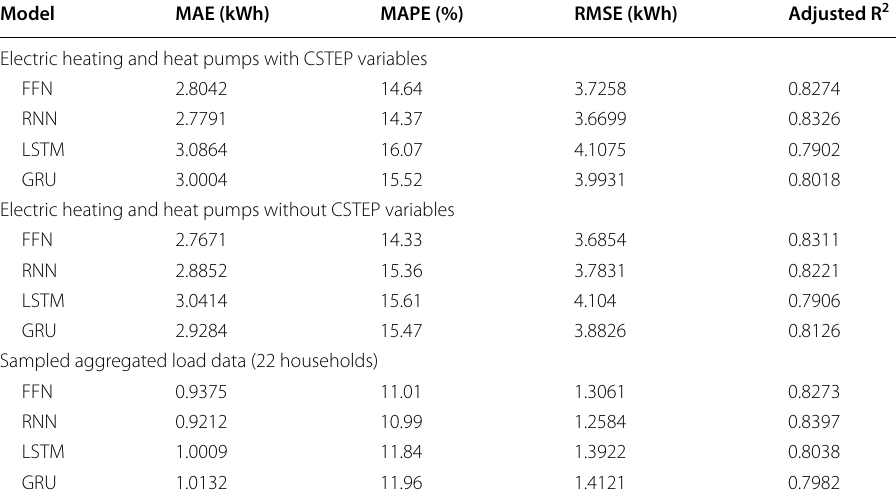
Table 8 Comparison metrics with electric heating load